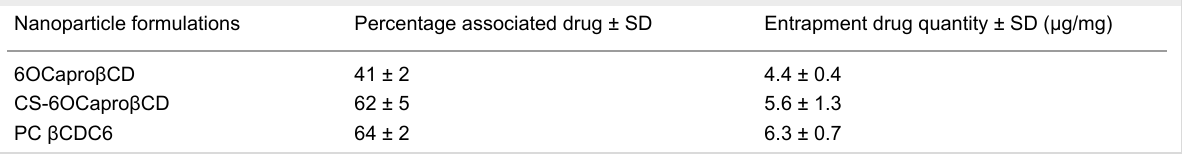
Table 3: Associated drug (%) and entrapment drug quantity (µg/mg) of amphiphilic CD nanoparticles for PCX (CD amount is 0.5 mg/mL and initial PCX amount is 0.05 mg/mL in all formulations) ( n = 3, ± SD). Nanoparticle